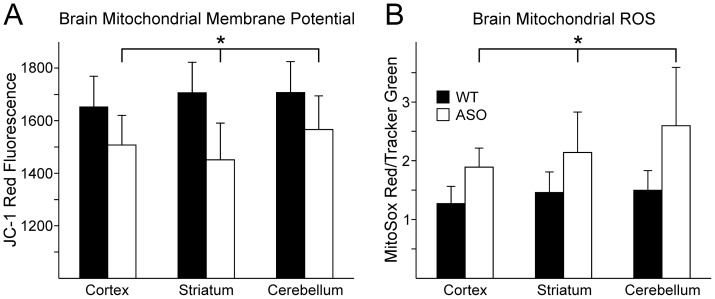
Overexpressed human α-synuclein disrupted brain mitochondrial functions.
A. The mitochondrial membrane potential, detected as JC-1 red fluorescence, was reduced in all ASOTg brain region mitochondria (cortex, striatum, cerebellum), and was significantly different from WT values when all brain regions were considered (Two Way ANOVA, P = 0.013)(* indicates that all brain regions must be included for significance between genotype, WT vs ASOTg). All values are expressed as mean ± Standard Error of Mean (SEM). However, Bonferroni post-hoc analyses showed no difference in membrane potential between brain regions [F (2,52) = 0.205, P = 0.815]. FCCP (10 µg/ml) decreased greater than 95% of membrane potential on average in separate experiments to confirm authentic mitochondrial membrane potential. B. Mitochondrial reactive oxygen species (ROS) were significantly elevated in all ASOTg brain regions relative to WT brain regions (Two Way ANOVA, P = 0.044) (* indicates that all brain regions must be included for significance between genotype, WT vs ASOTg). There was no difference in ROS between brain regions [F (2,30) = 0.156, P = 0.857].